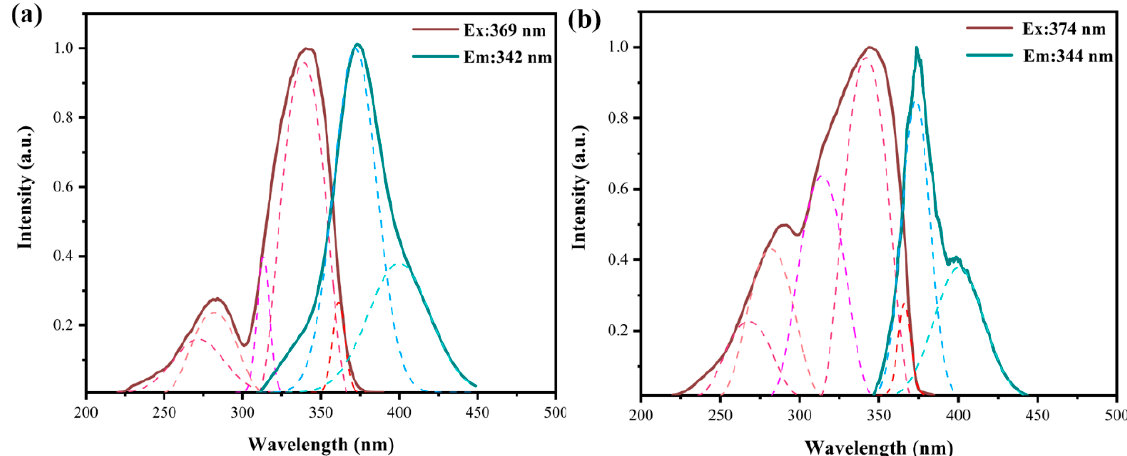
Figure 4. Normalized photoluminescence excitation and emission spectra of ( a ) CKLC and ( b ) CKCC crystals.